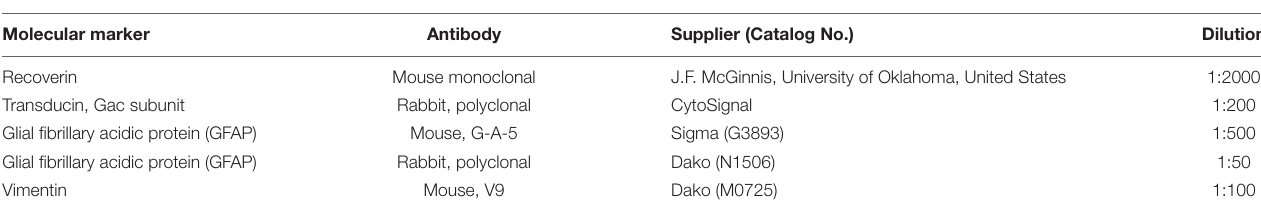
TABLE 1 | Antibodies used for immunofluorescence. Molecular